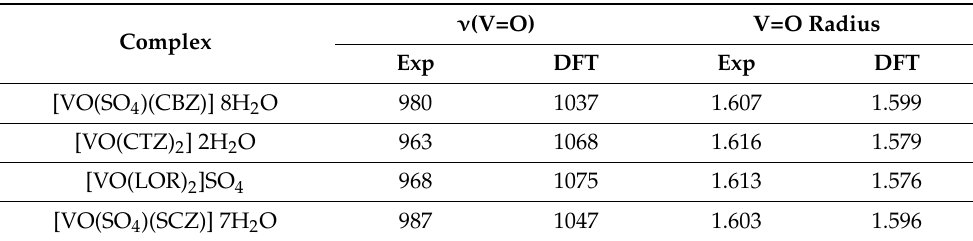
Table 6. Bond lengths and stretching frequencies for V=O Bonds in synthesized oxidovanadium(IV) complexes, experimental, and theoretical